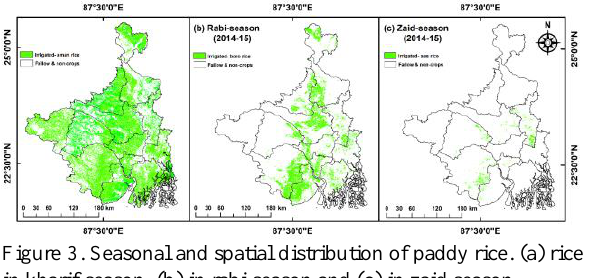
Figure 3. Seasonal and spatial distribution of paddy rice. (a) rice